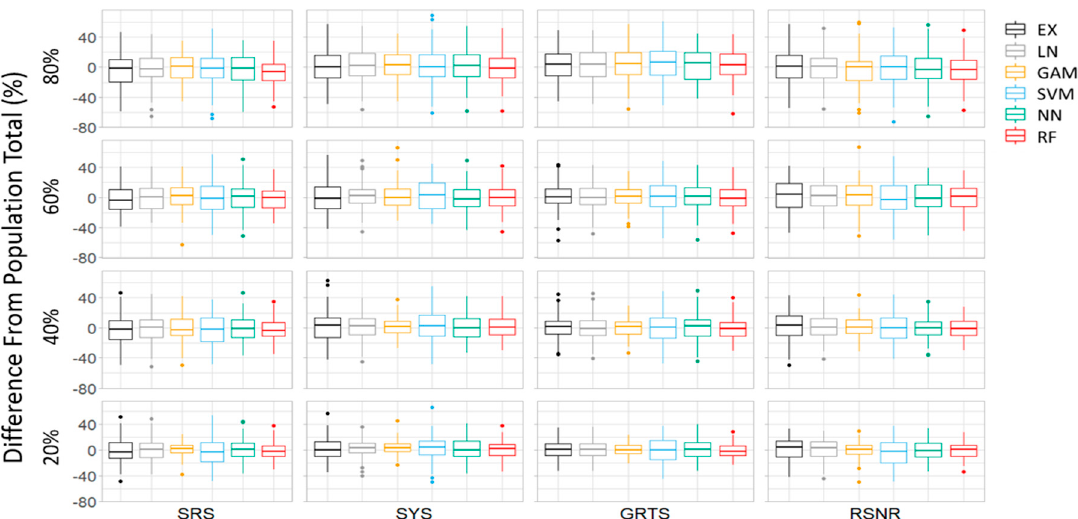
Figure 7. Distribution of estimation errors for response surface population totals. Estimation errors are expressed as a percentage of the population total for trend response surfaces with normally distributed errors based on 20%, 40%, 60%, and 80% of the total nonlinear SC1 image standard deviation. Column and row titles identify sample designs and proportion of SC1 standard deviation used in response surfaces. Ex = expansion; LN = linear; GAM = general additive model; SVM = support vector machine; NN = neural networks; RF = random forests; SRS = simple random sample; SYS = systematic random sample; GRTS generalized random tessellation stratified; and RSNR = random sample near roads.